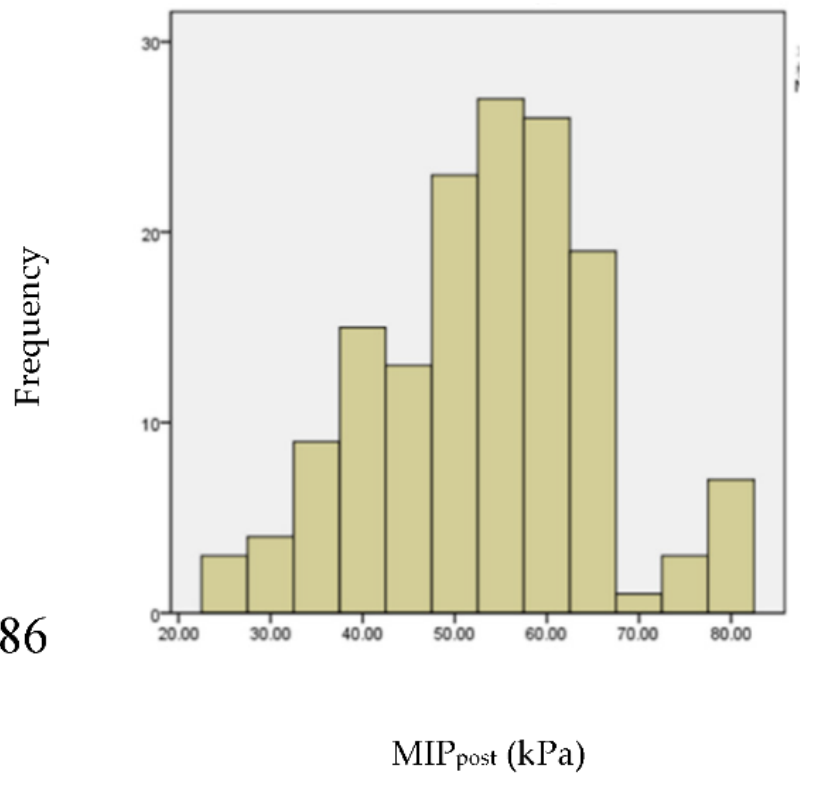
Figure 1. The histogram of the maximum isometric pressure of the posterior tongue.